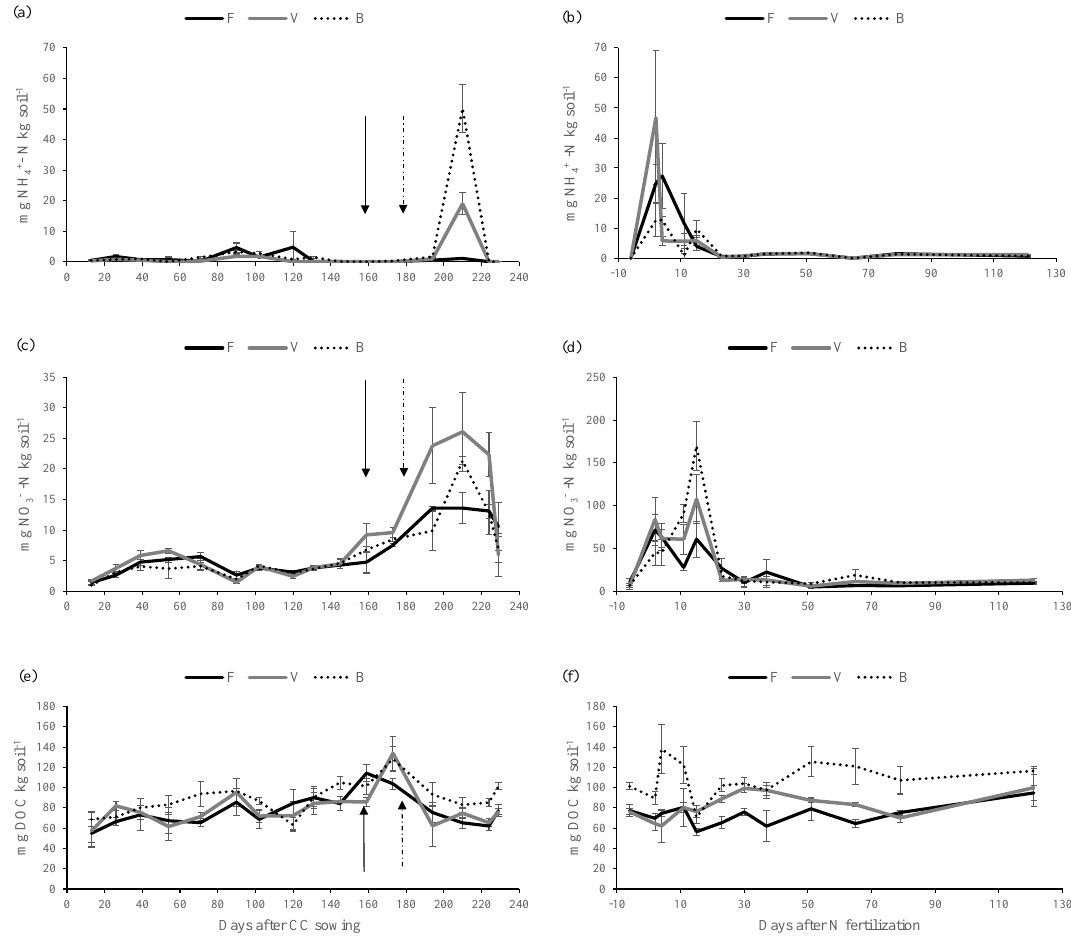
fig02 Figure 2. (a, b) NH + -N, (c, d) NO − -N and (e, f) DOC concentrations in the 0–10cm soil layer for the three CC treatments (fallow, F; vetch, 4 3 V; and barley, B) during both cropping periods. The black arrows indicate the time of spraying glyphosate over the CCs. The dotted arrows indicate the time of maize sowing. Vertical lines indicate standard